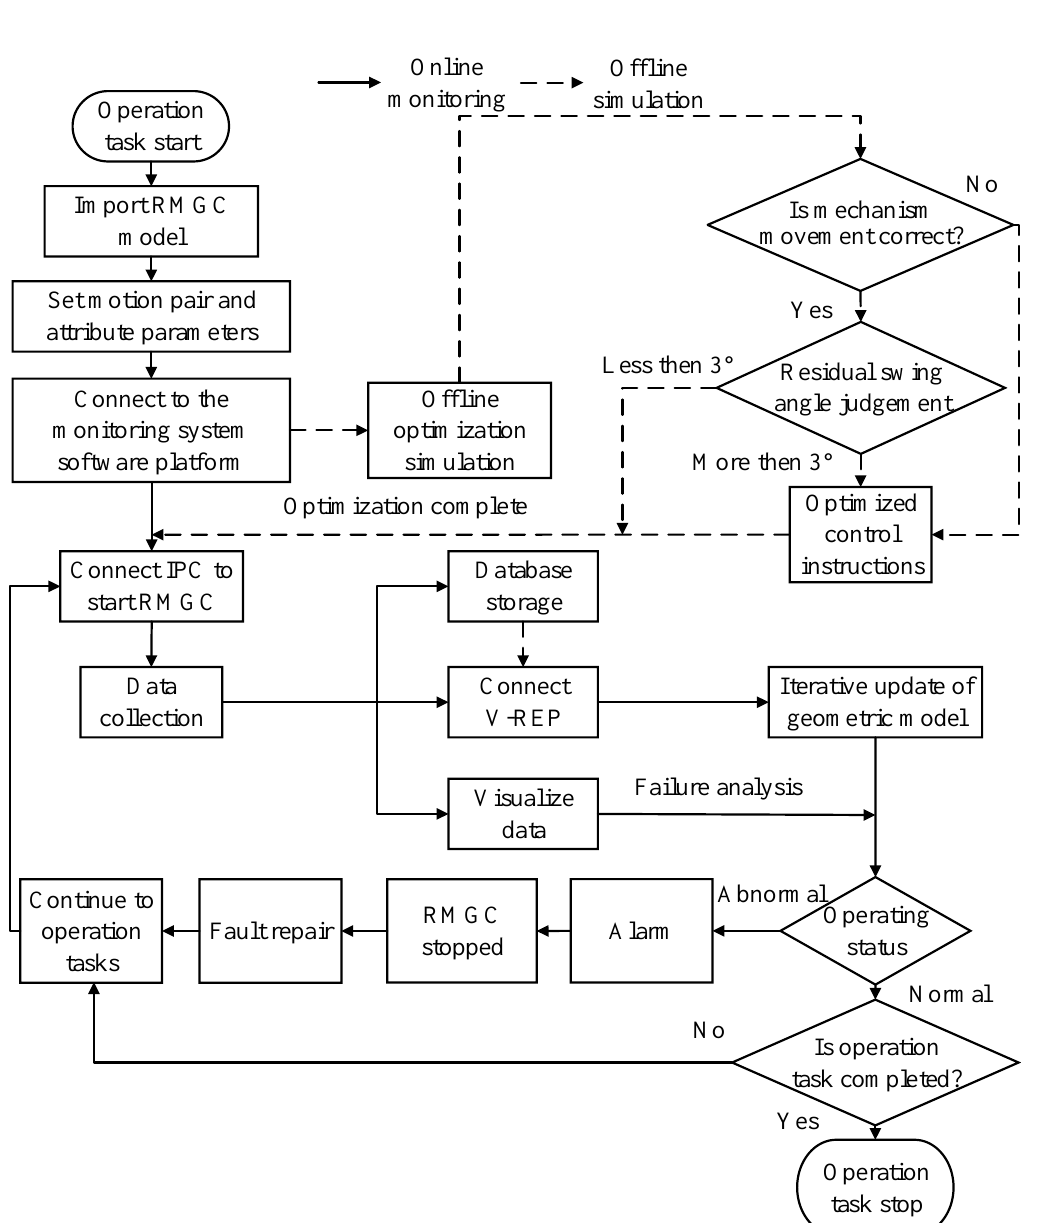
Figure 7. Flowchart of monitoring and control of the digital twin-driven RMGC.